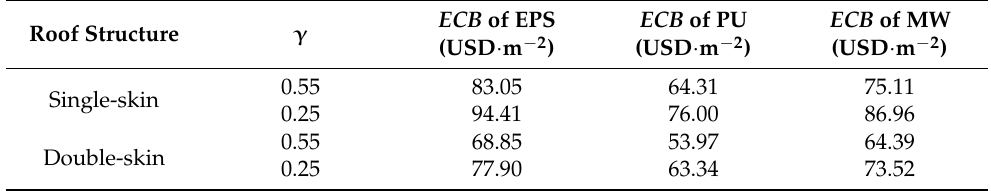
Table 5. Economic benefits of thermal insulation.